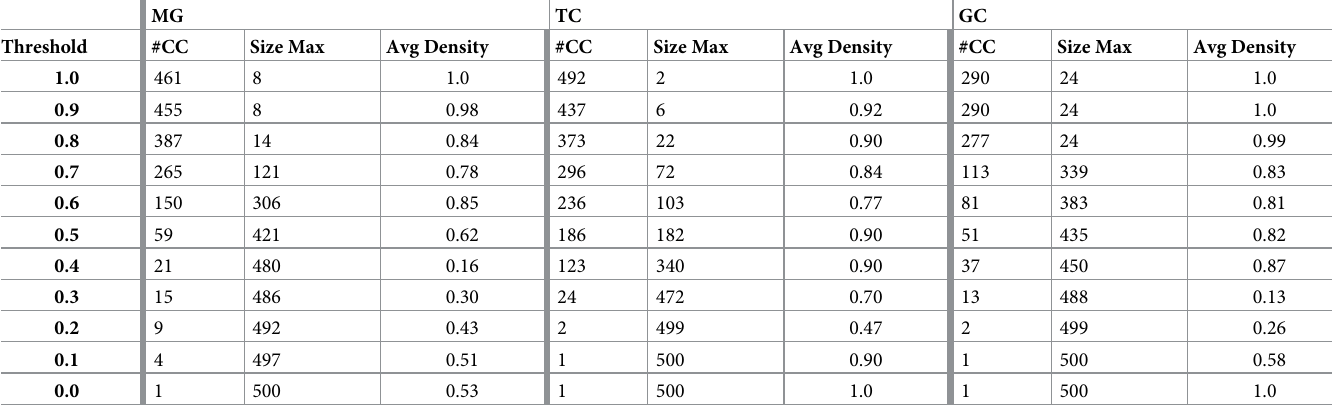
Table 5. Connected components, size and average density of connected components on MG, TC, and GC on M